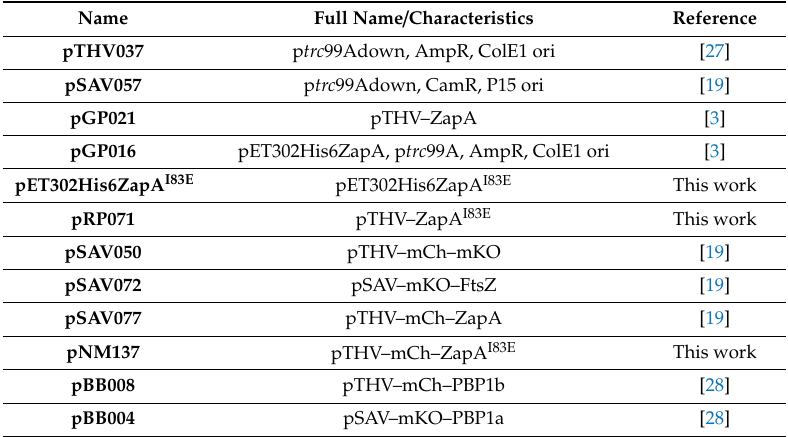
Table 2. Plasmids used in this